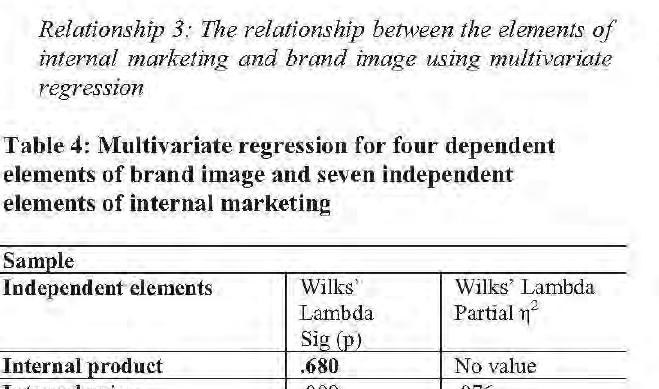
Table 4: Multivariate regression for four dependent elements of brand image and seven independent elements of internal marketing